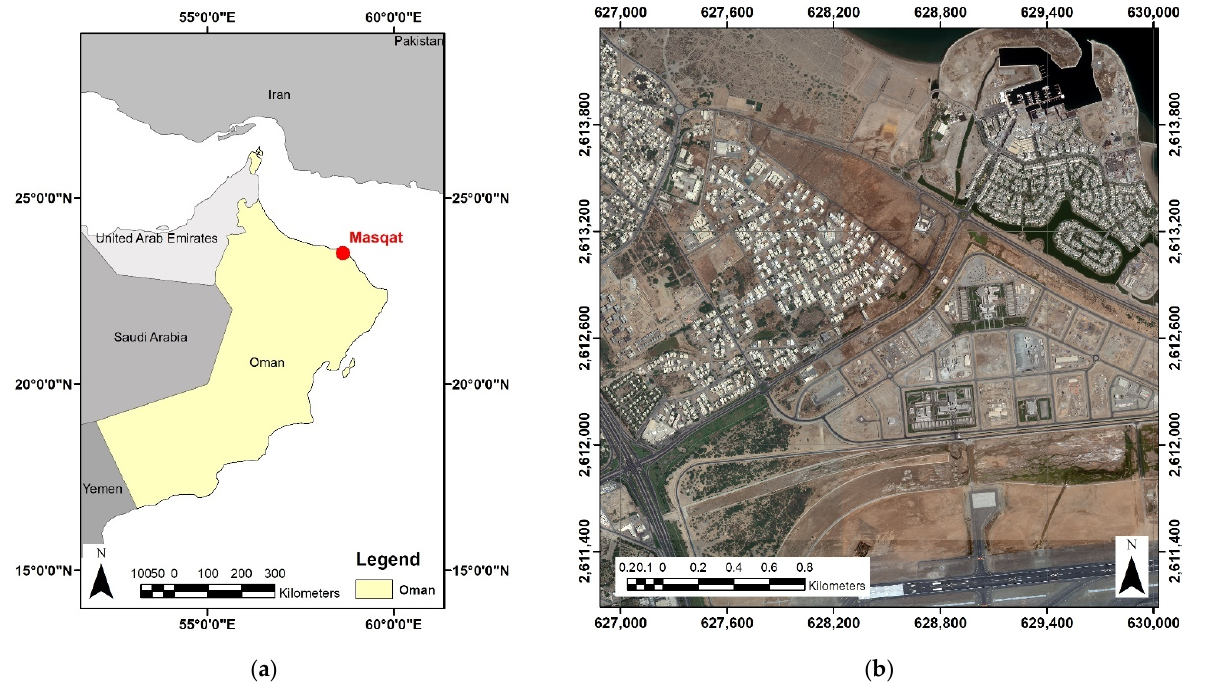
Figure 1. Study area: Identification of Oman in geographic coordinates ( a ); true color digital orthophoto imagery in Universal Transverse of Mercator (UTM) fuse 40N projection ( b ).